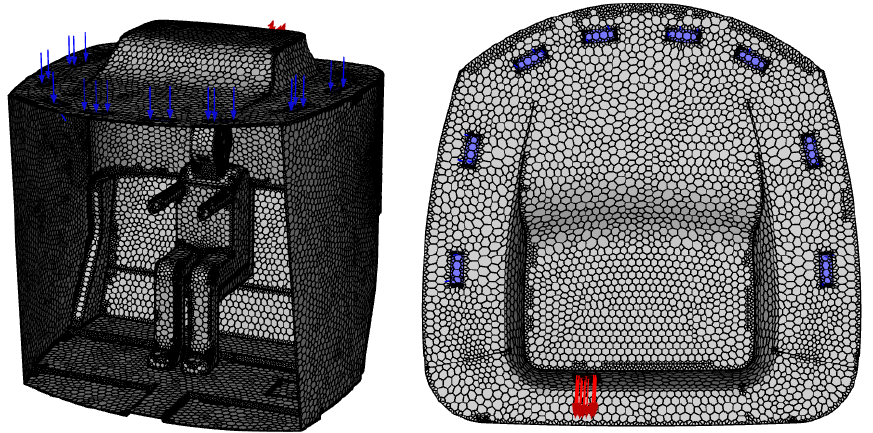
Figure 4. Mesh of finite volumes.